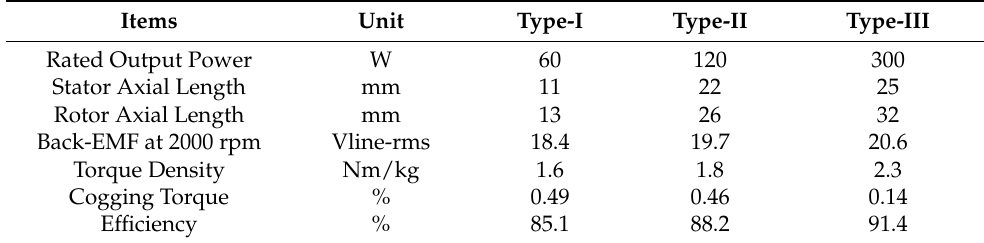
Figure 11. 3D configuration of final model for each joint motor. Table 5. Performance of the Designed Joint Motors.